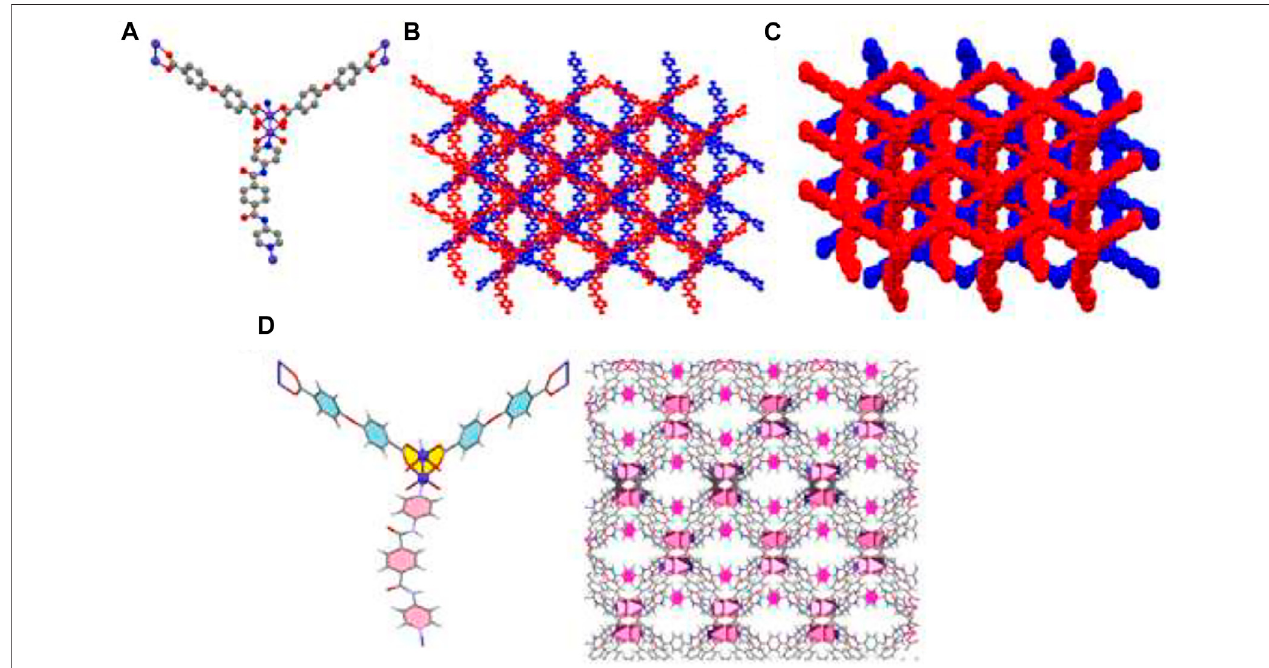
FIGURE 2 | Molecular diagram of TMU-50 (A) , showing 3D structure (B) , the two-fold interpenetration of TMU-50 (C) , and representation of the arrangement of bpta pillar ligands inside the channel walls (with pore scale of 12.84Å). The benzene are colored pink (D)